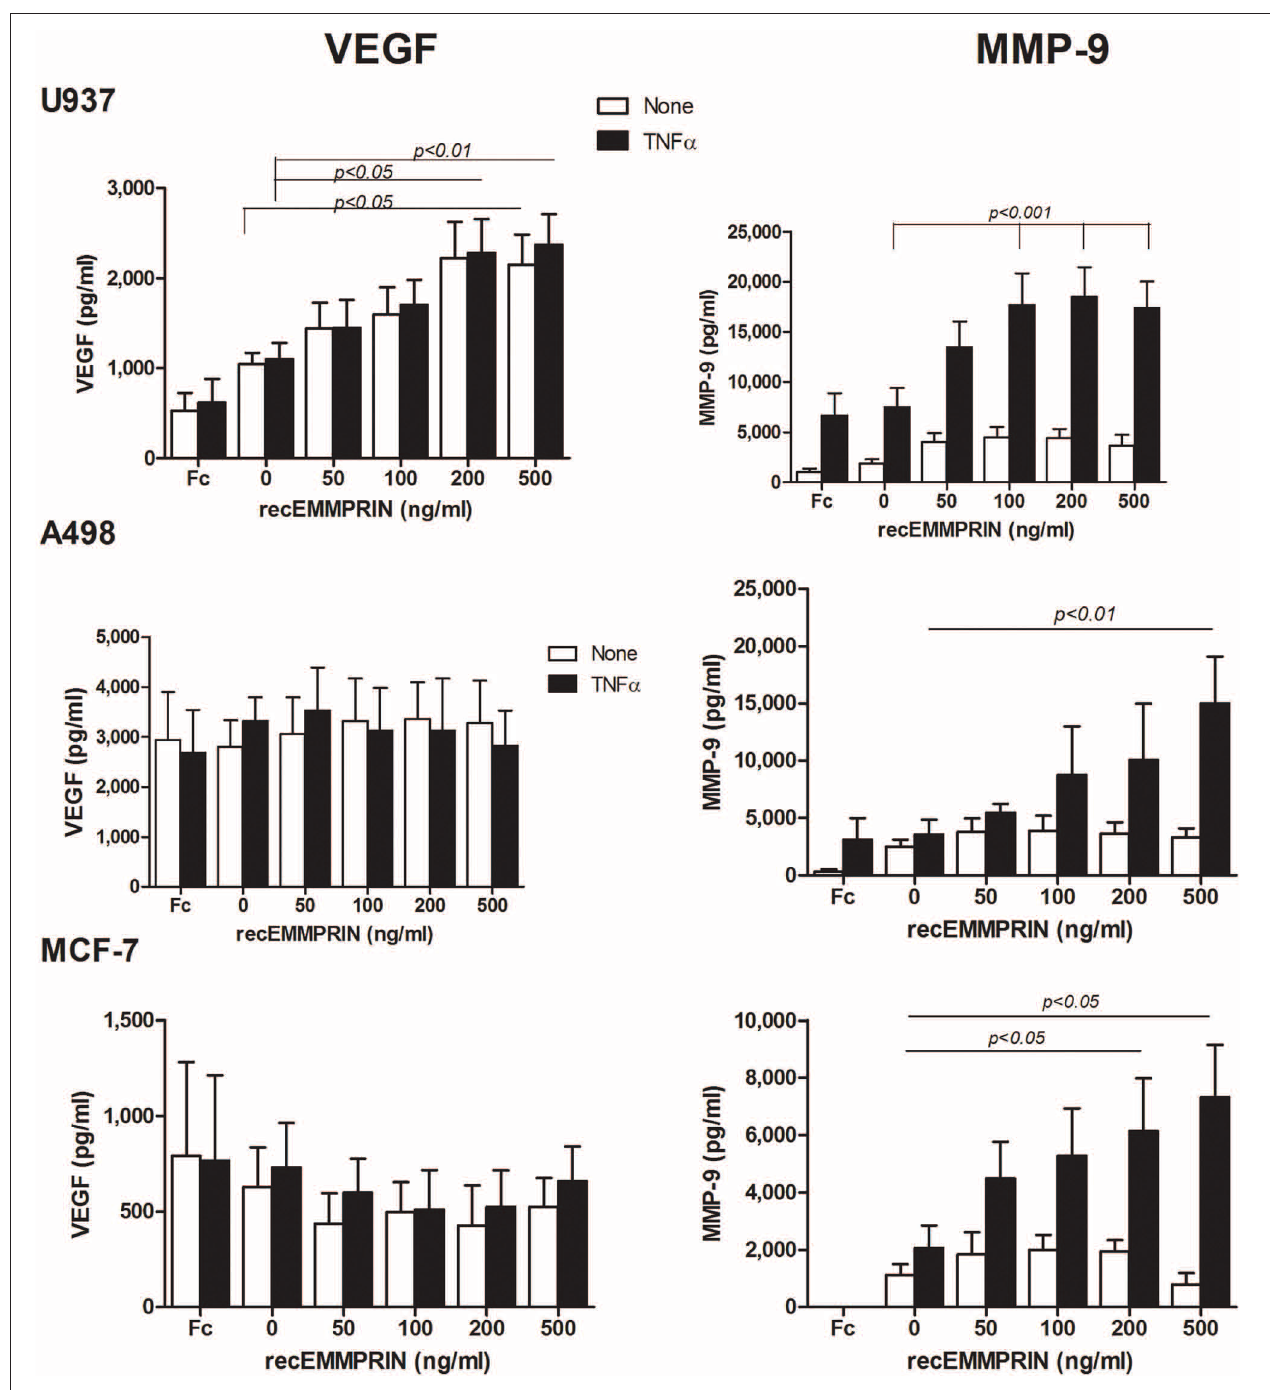
and with the addition of increasing amounts of recombinant EMMPRIN or the IgG Fc fragment (at 200ng/ml). Concentrations of MMP-9 and VEGF were determined in the supernatants using ELISA ( n =